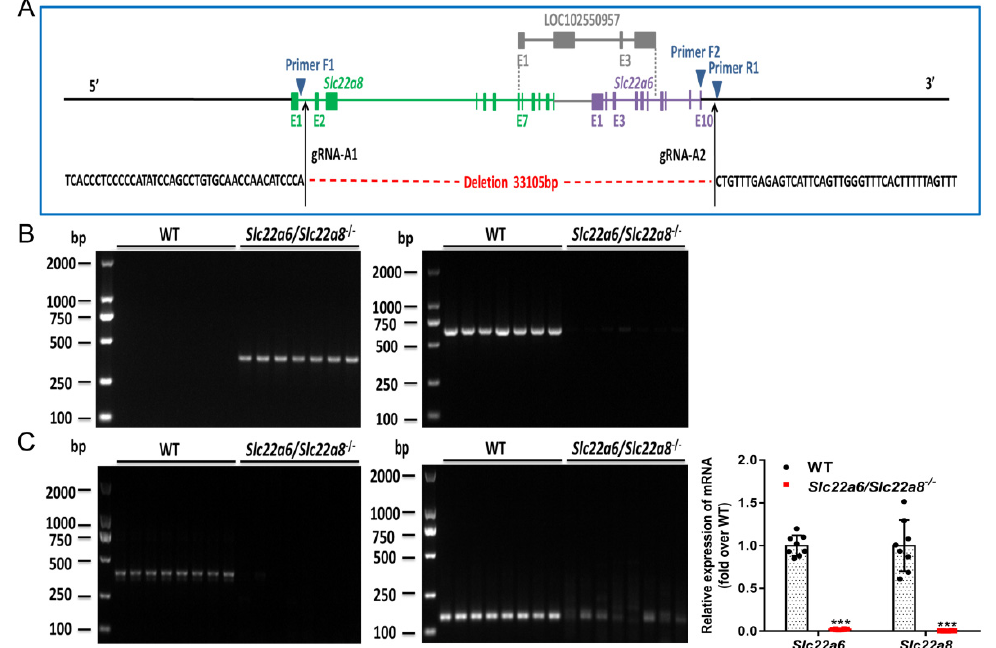
Figure 1. Development and validation of the Slc22a6/Slc22a8 double-knockout model. PCR and Q-PCR were used to verify the Slc22a6/Slc22a8 knockout model. ( A ) Schematic of the targeted deletion of Slc22a6 and Slc22a8 . The black arrows indicate the target sites. The positions of the PCR primers used to detect the wild-type allele and targeted allele are shown with blue triangles. ( B ) Agarose gel electrophoresis of the PCR Primers1 amplification product with 370 bp targeted allele ( left ) and PCR Primers2 amplification product with 613 bp wild-type allele ( right ) (n = 7). ( C ) Agarose gel electrophoresis of the Q-PCR amplification products of Slc22a6 ( left ) and Slc22a8 ( middle ) primers (n = 8). The mRNA expression of Slc22a6 and Slc22a8 in the kidneys of WT and KO rats (right). *** p < 0.001 compared with WT rats.